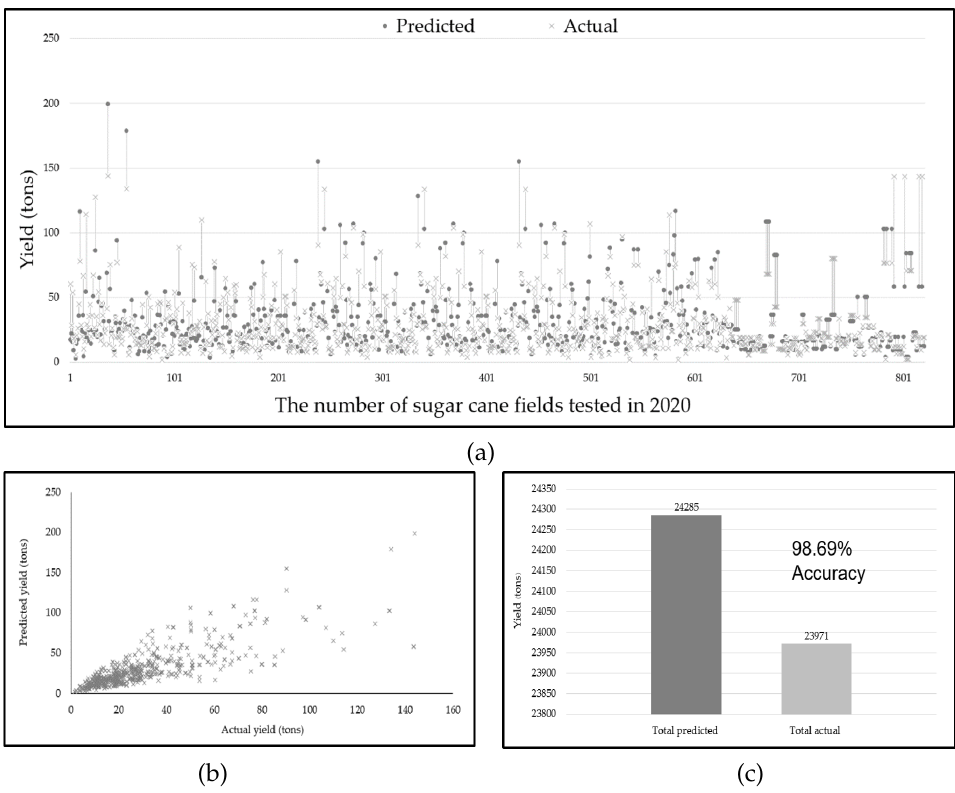
Figure 16. Test results when the finished model was run on Classified Data Subset C: ( a ) The difference between each predicted yield and actual yield is displayed as a line. ( b ) The correlation between predicted yield and actual yield. ( c ) Total predicted yield compared with total actual